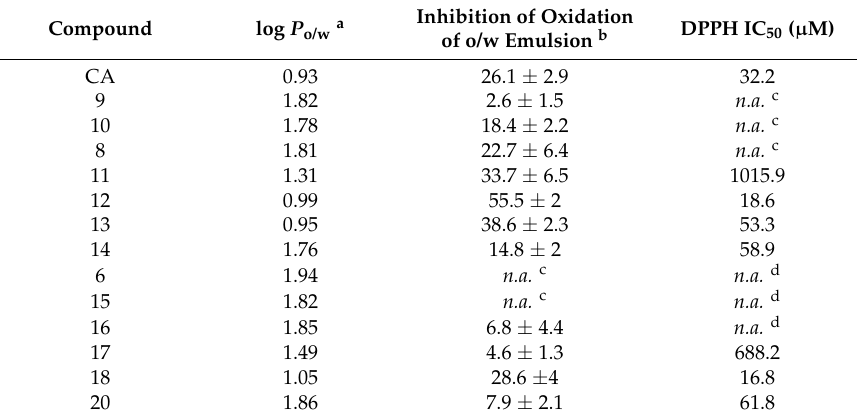
Table 2. Log P o/w , and the antioxidant activity of the tested